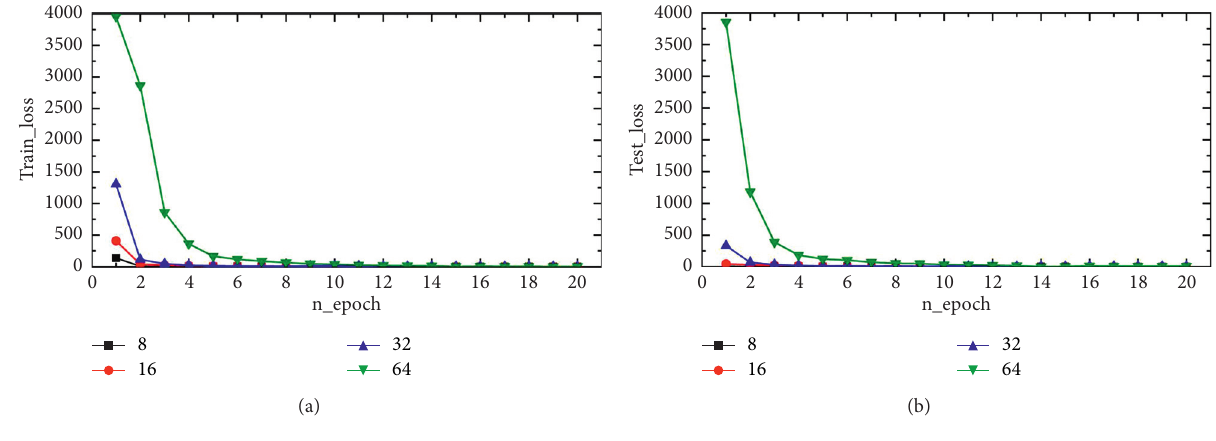
Figure 6: Loss curve under different